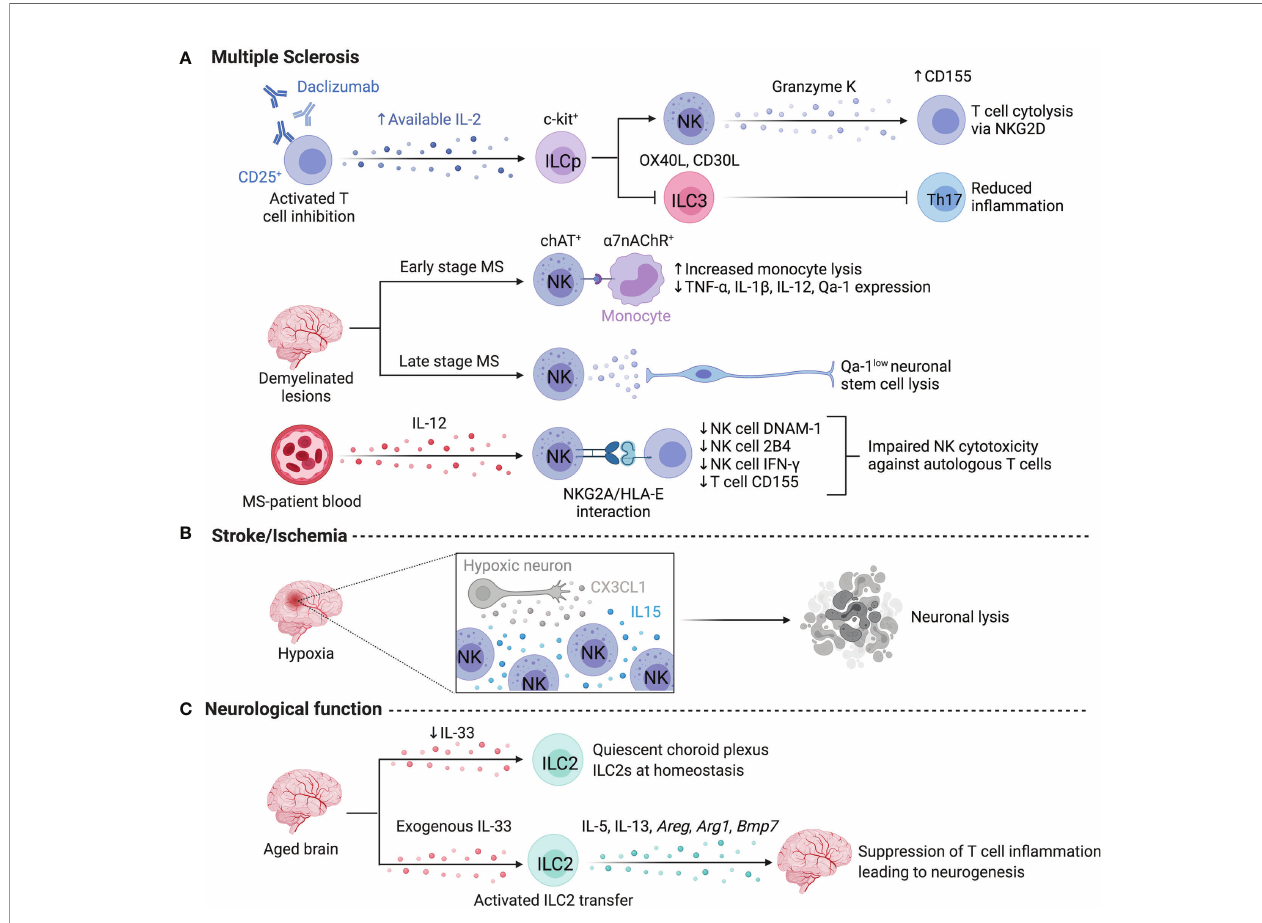
FIGURE 3 | ILCs in the nervous system. Limited information exists on human ILCs in the nervous system at steady state due to challenges in obtaining samples, however, several studies focus on ILC activity in multiple sclerosis or stroke. (A) Daclizumab-driven inhibition of T cells resulted in the expansion of NK cells and the elevated lysis of T cells. Daclizumab treatment lowers the abundance of Lin - c-kit + RORC2 + ILCs and dampens Th17-associated in fl ammation by lowering IL-17 and GM-CSF. ChAT + NK cells preferentially localize to demyelinated lesions in the human brain to dampen monocyte-driven in fl ammation via the a7-nicotinic acetylcholine receptor (a7nAChR), rendering myeloid cells more susceptible to lysis at early stages of MS. Conversely, NK cell-mediated lysis negatively impacts regeneration during later stages of MS by targeting, Qa-1 low neuronal stem cells. NK cell activation may be impaired by NKG2A/HLA-E interactions with autologous CD4 + T cells. (B) After a stroke, CX3CL1 from hypoxic neurons recruits NK cells, while local IL-15 levels facilitate NK cell enrichment and promote high NKG2D expression and neuronal lysis. (C) ILC2s impact neurological functions in murine brain and are supported by exogenous IL-33 to suppress T cell in fl ammation and enhance neurogenesis. Created with